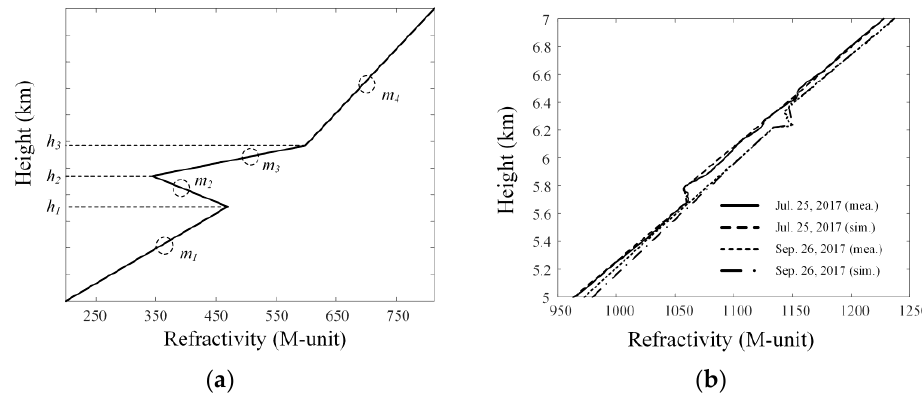
Figure 2. Modified refractivity according to height: ( a ) the quad-linear refractivity model; ( b ) com- parisons between the actual refractivity data and the quad-linear models.